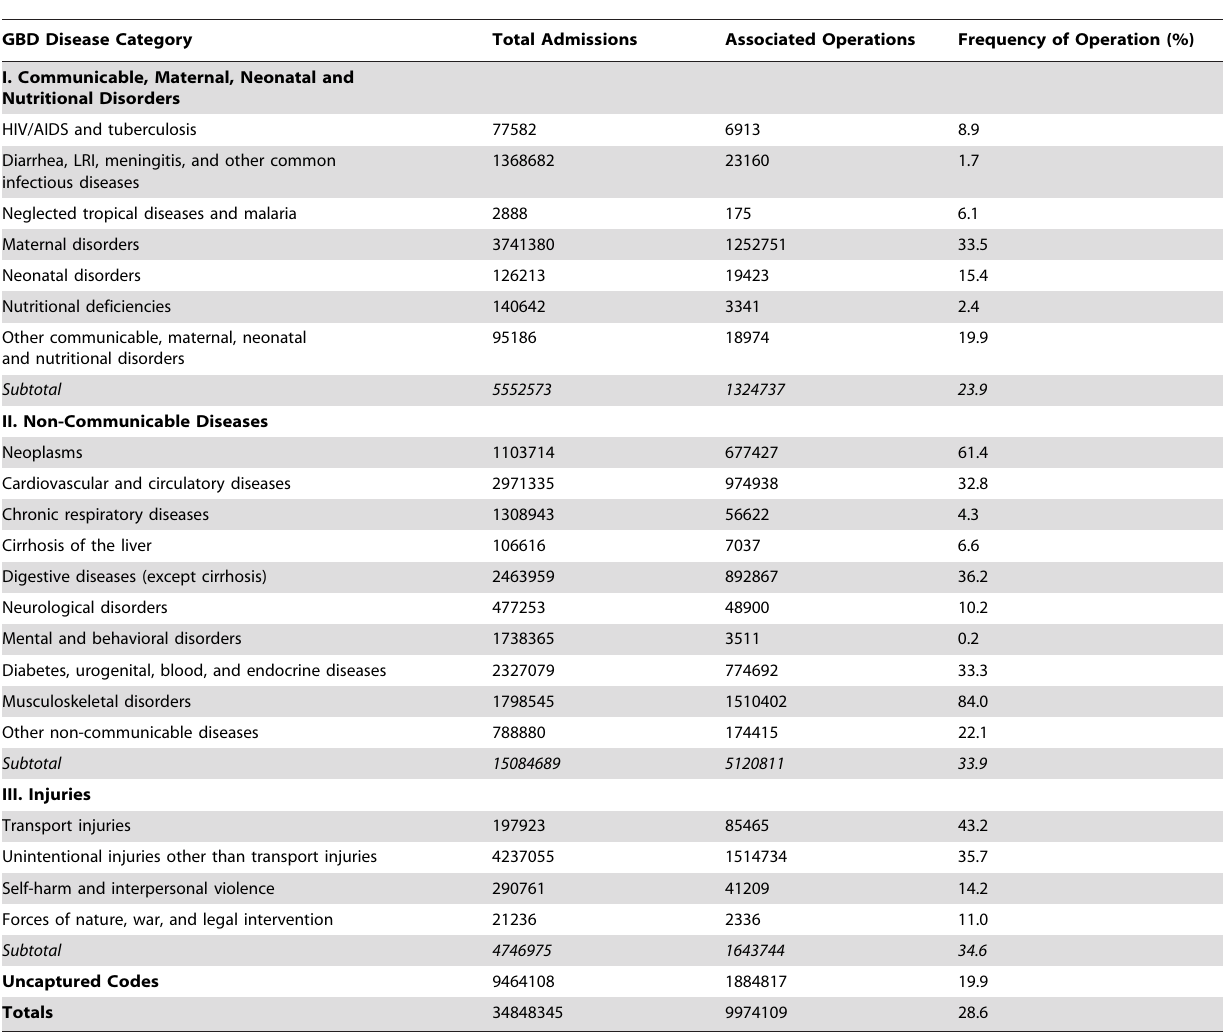
Table 1. Hospital admissions and frequency of operations by GBD disease